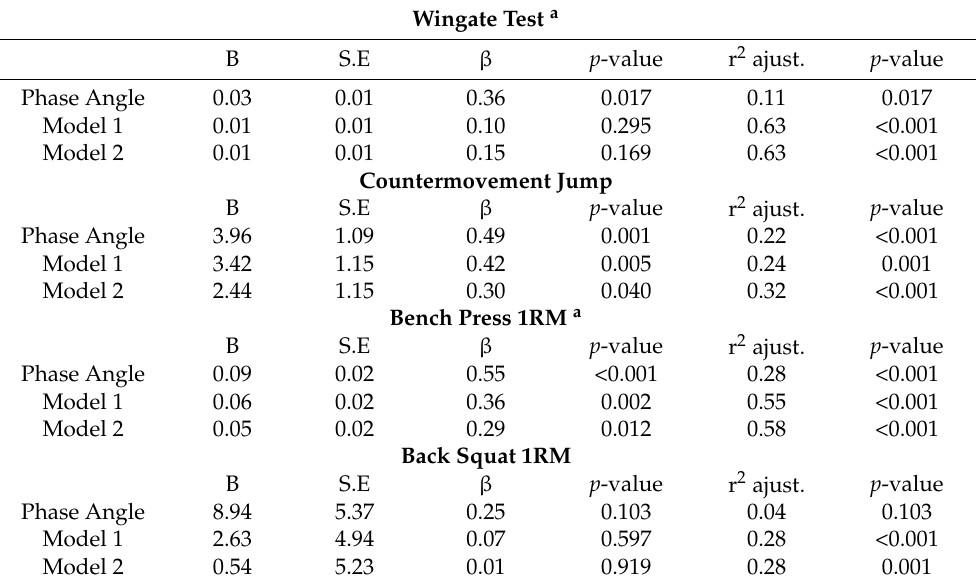
Table 3. Associations between phase angle and performance in power and muscle strength